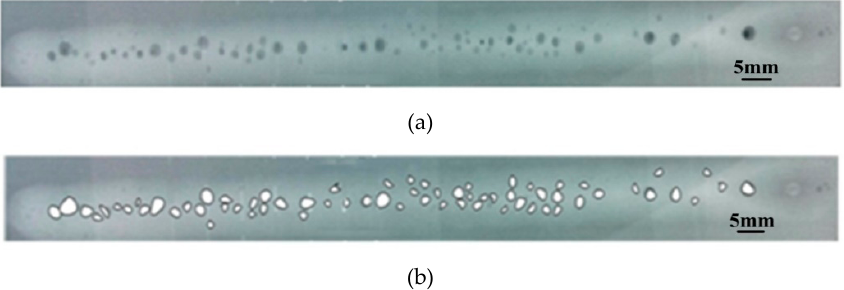
Figure 2. X-ray NDT photos of a typical aluminum alloy weld ( a ) and extraction of the weld pore area ( b ) ( I = 160 A).